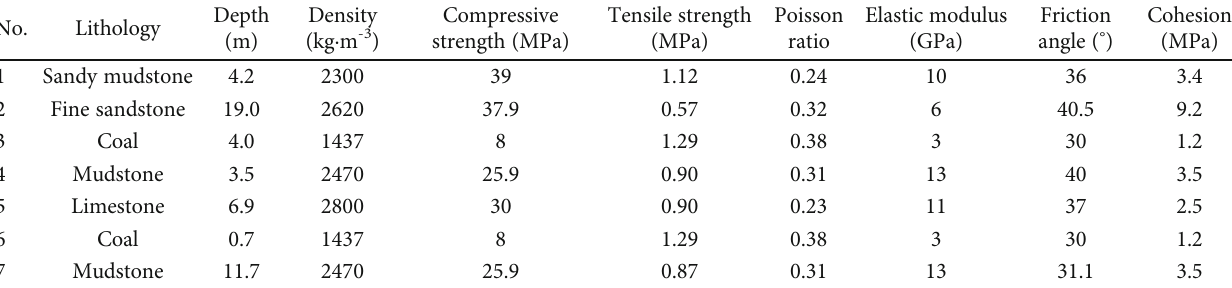
Table 1: Strata structure and mechanical parameters of